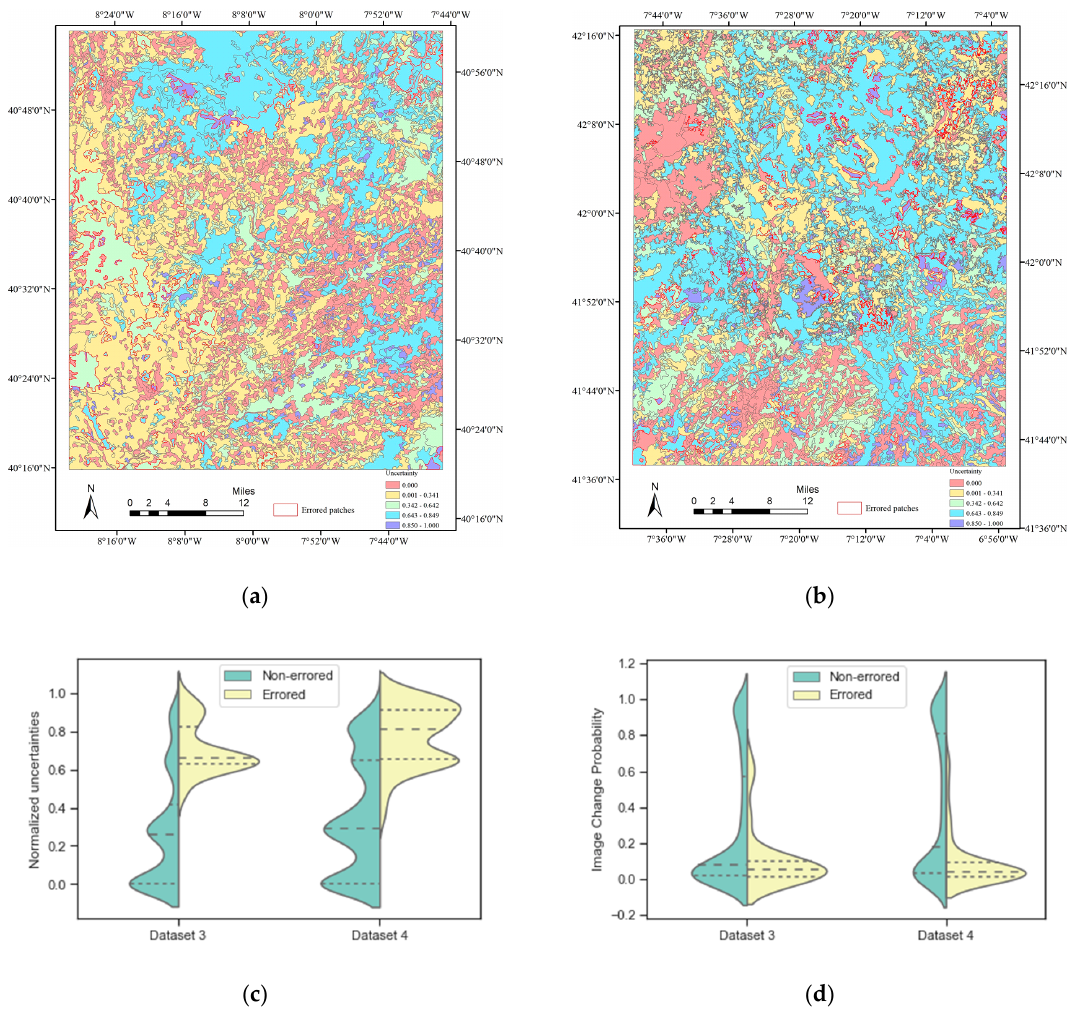
Figure 8. Spatial distribution of final uncertainty in ( a ) Dataset 3 and ( b ) Dataset 4, and violin plots of errored and non-errored patches in Datasets 3 and 4 showing ( c ) patch label uncertainty and ( d ) image change probability.